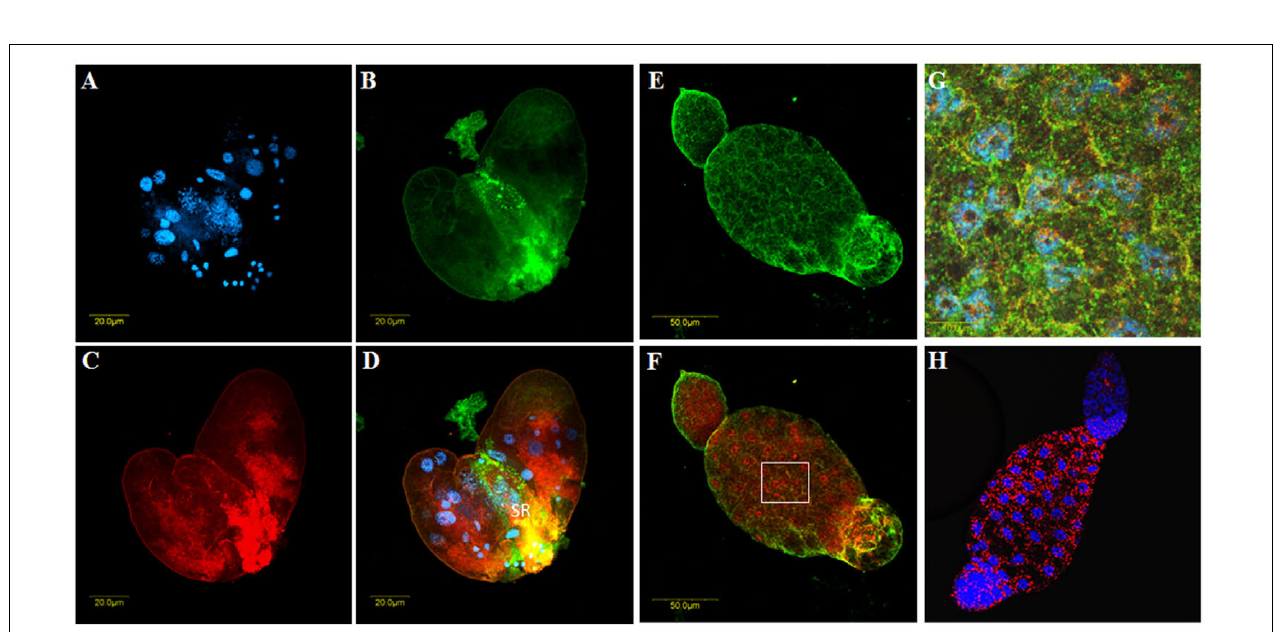
FIGURE 5 | Co-immunolocalization of TYLCV with first antibody against the virus CP and detected with secondary antibody conjugated to Cy3 (A , red), and CypB reacted with polyclonal anti-CypB first antibody and detected with secondary antibody conjugated to Cy2 anti-rabbit secondary antibody ( B , green) in B. tabaci midguts dissected from viruliferous adults. (C) Shows the overlay of (A and B) and the yellow spots show the colocalization. (D–F) Are zoom in of the portions shown in the insets that appear in (A–C) , respectively. (G) Is a control gut in which the whole co-immunolocalization procedure was performed without adding the anti-CypB primary antibody, and (H) is a control gut in which only secondary antibodies were used. ca, cecae; fc, filter chamber; am, ascending midgut; dm, descending midgut.